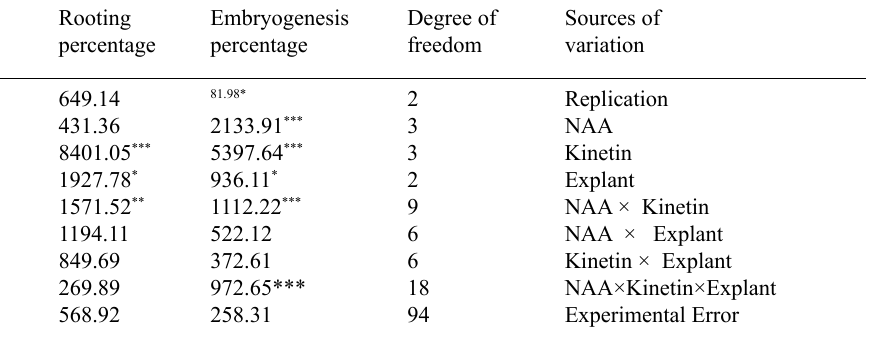
table 1. Analysis of variance was conducted on the evaluated traits to study embryogenesis in different explants of chamomile at different levels of growth regulators (NAA) and